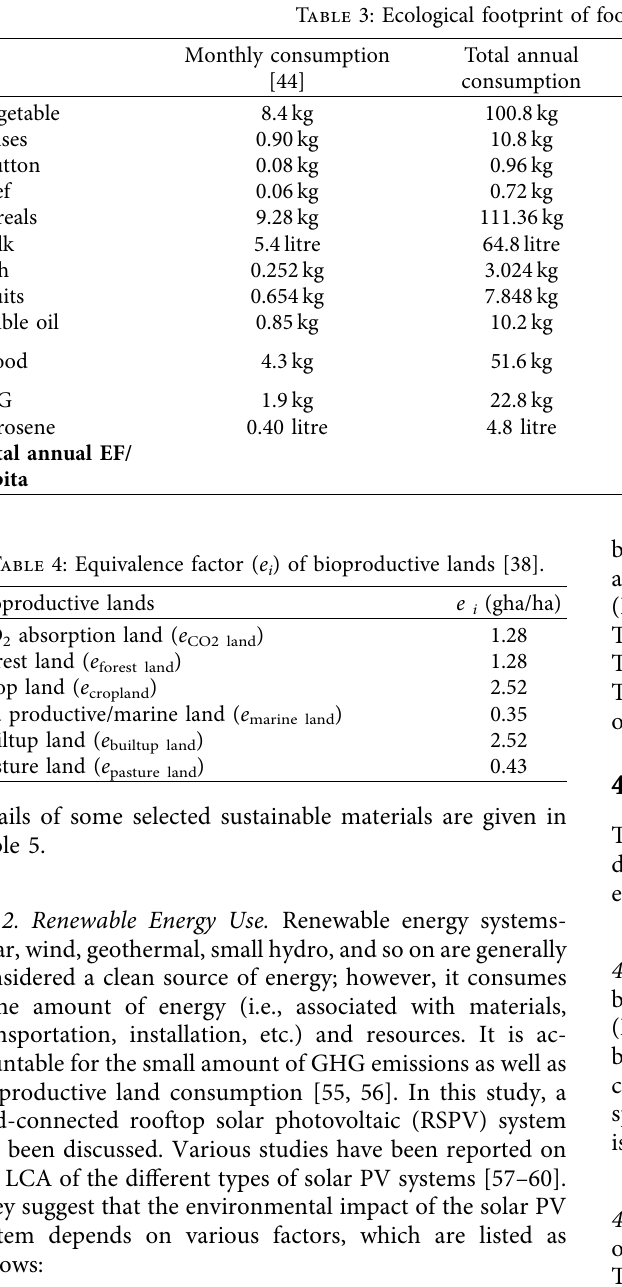
Table 3: Ecological footprint of food goods per capita in India.